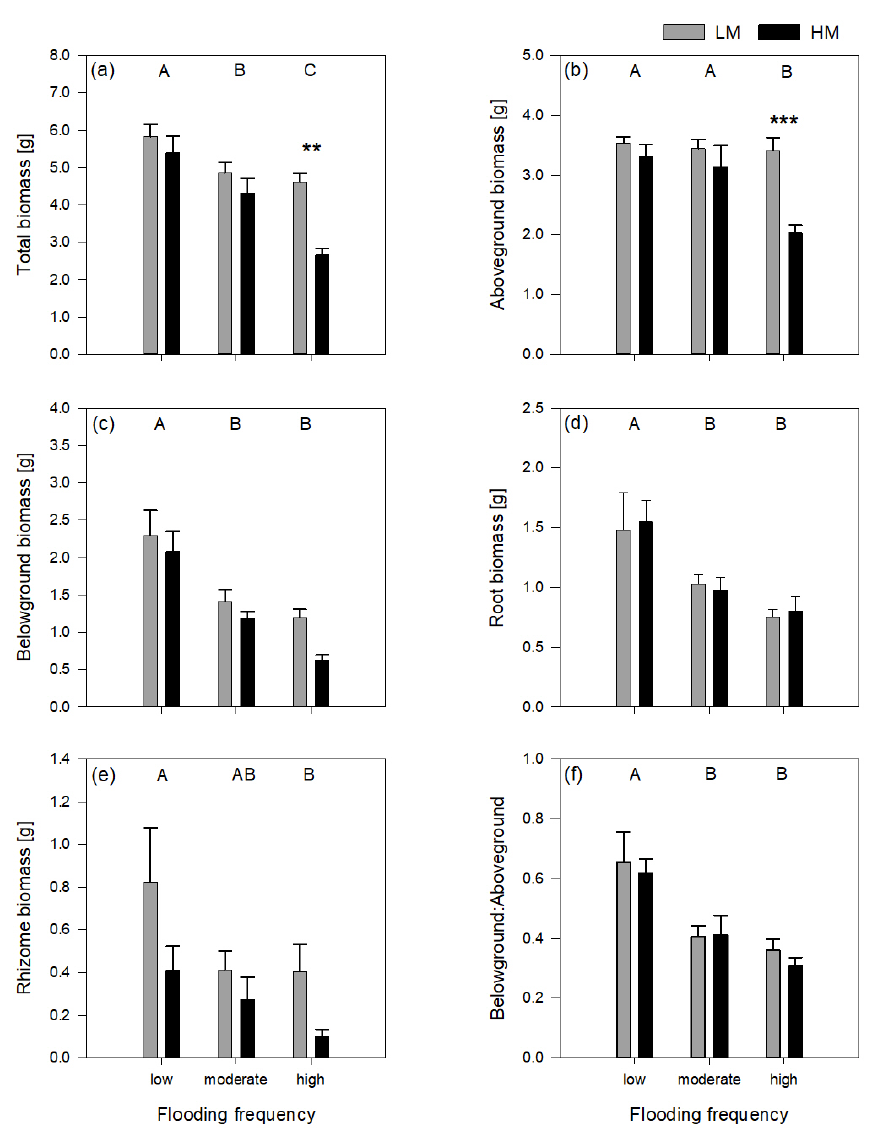
Figure 1. Total biomass (a) , aboveground biomass (b) , belowground biomass (c) , root biomass (d) , rhizome biomass (e) and belowground– aboveground ratio (f) of both genotypes on three different flooding frequencies (mean + standard errors). Stars show significant differ- ences between low-marsh (LM) and high-marsh (HM) genotypes within the same flooding treatment based on Tukey’s HSD post hoc test ( ∗ p < 0.05; ∗∗ p < 0.01; ∗∗∗ p < 0.001). Capital letters indicate significant differences between flooding frequencies. For statistics